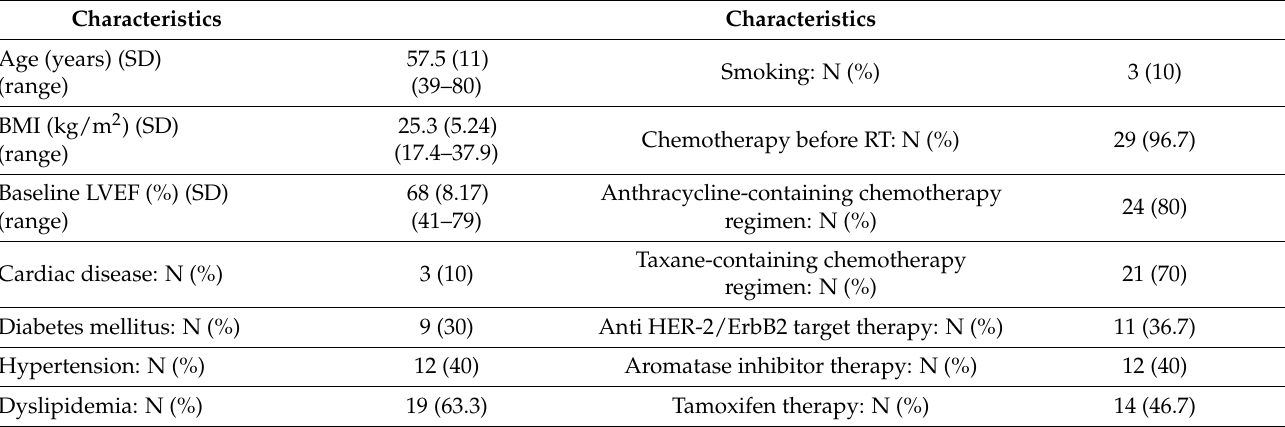
Table 1. Patient Table 1. Patient characteristics.